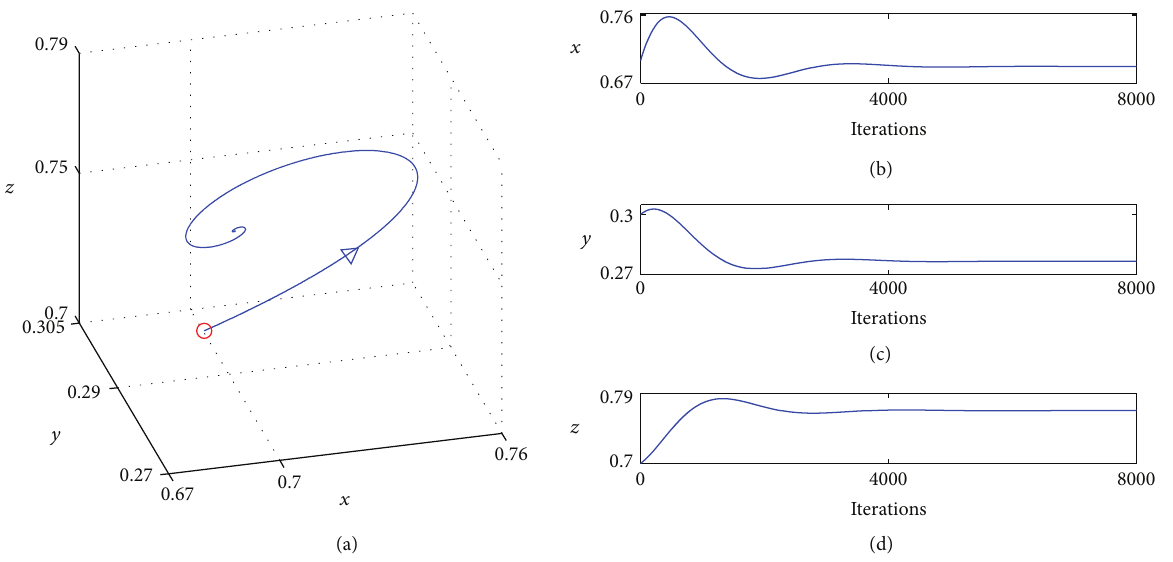
Figure 4: (a) A phase portrait of system (1) with initial condition (0.7, 0.3, 0.7) and (b)–(d) time series for 𝑥 1 (𝑡), 𝑥 2 (𝑡) , and 𝑦(𝑡) , respectively, when 𝑎 1 = 0.8, 𝑏 1 = 0.5, 𝑎 2 = 1.0, 𝑏 2 = 1.0, 𝑐 = 0.8, 𝑑 = 0.199, 𝑒 1 = 0.3, 𝑒 2 = 0.5, 𝛼 = 1.0 , and 𝛽 = 0.7 .